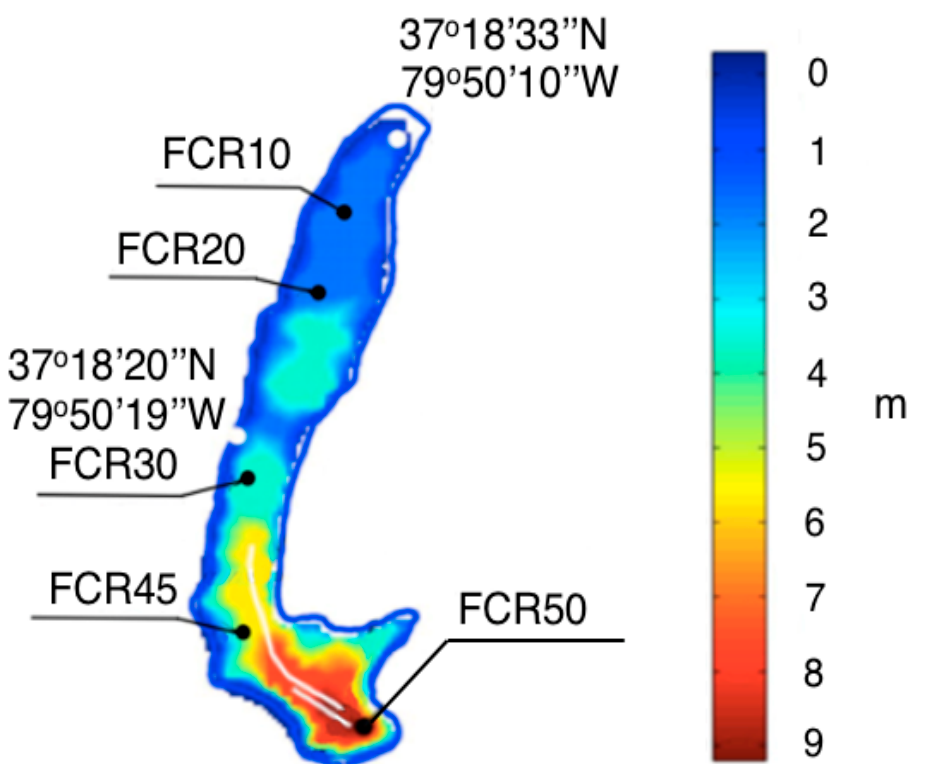
Figure 1. Bathymetry contours of Falling Creek Reservoir (FCR) and field data collection sites. The locations of the side stream supersaturation (SSS) system (short white line) and the epilimnion mixing (EM) system (long white line) are also shown. Table 1. Information about the operation of the oxygenation system in the years 2014 and 2015 and the corresponding simulation periods.